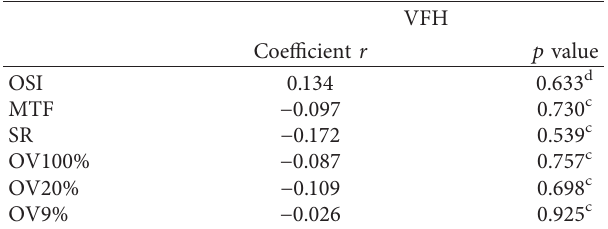
Figure 5: The correlations between VFH and total HOA RMS, 3rd RMS, and vertical coma of the anterior cornea surface. ∗ p < 0 . 05. Table 5: The correlation between the OQAS parameters and